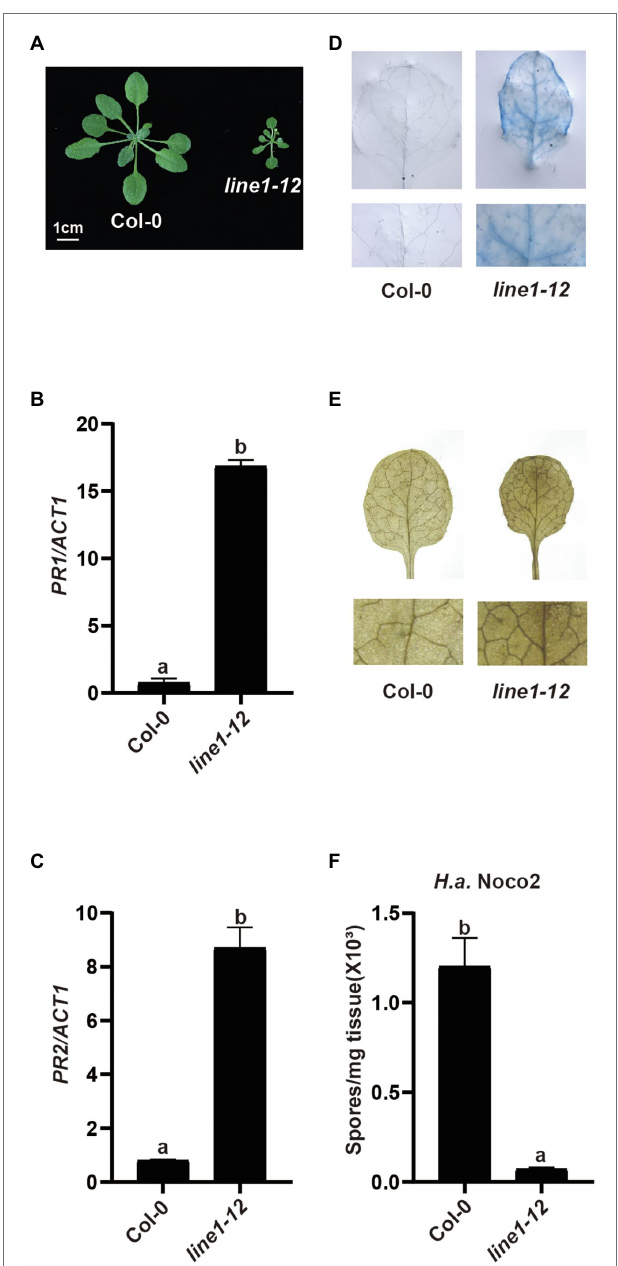
FIGURE 1 | Characterization of line1-12 . (A) Morphology of 3-week-old soil-grown plants of wild-type (Col-0) and line1-12 under long-day conditions. (B,C) Expression of PR1 (B) and PR2 (C) in indicated genotypes. ACTIN1 serves as internal control. Total RNA was extracted from 3-week-old seedlings grown on soil. Error bars represent means of 3 biological replicates ± SD. Statistical differences among the samples are labeled with different letters ( p < 0.05, one-way ANOVA; n = 3). (D) Trypan blue staining of 3-week- old Col-0 and esd4-3 mutant leaves. (E) DAB staining of 3-week-old Col-0 and esd4-3 mutant leaves. (F) Quantification of H.a. Noco2 conidia spores on indicated genotypes. 1 × 10 5 spores/ml inoculum were spray-inoculated on 2-week-old soil-grown seedlings. Numbers of spores were counted at 7 days post-inoculation. Error bars represent means of 3 biological replicates ± SD. Statistical differences among the samples are labeled with different letters ( p < 0.05, one-way ANOVA; n =